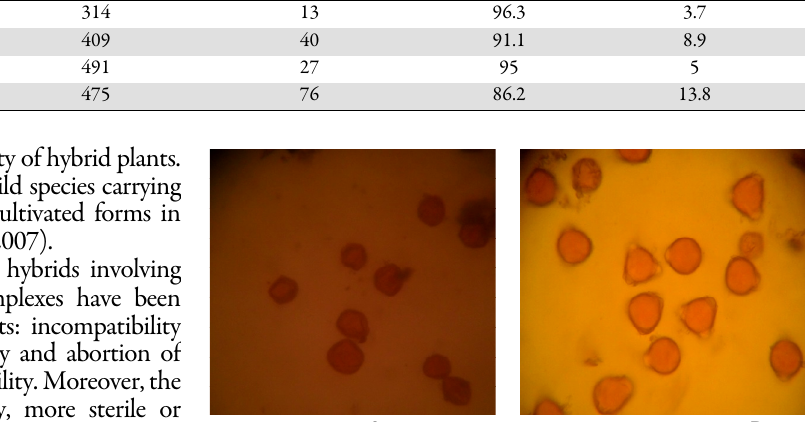
Table 2. Pollen viability in the studied Capsicum genotype Varieties